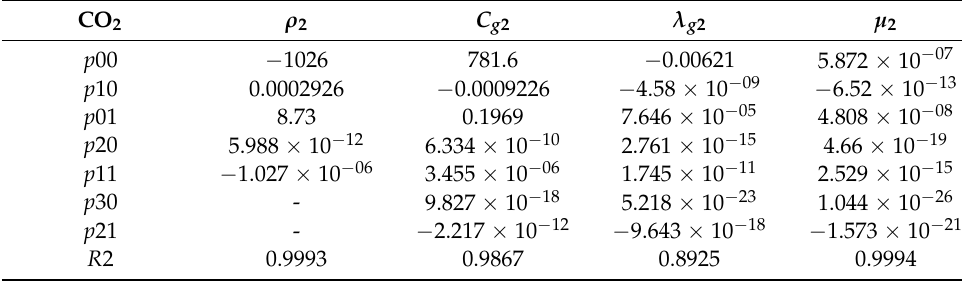
Table 3. The correlation coefficient of the fitted equation for CO 2